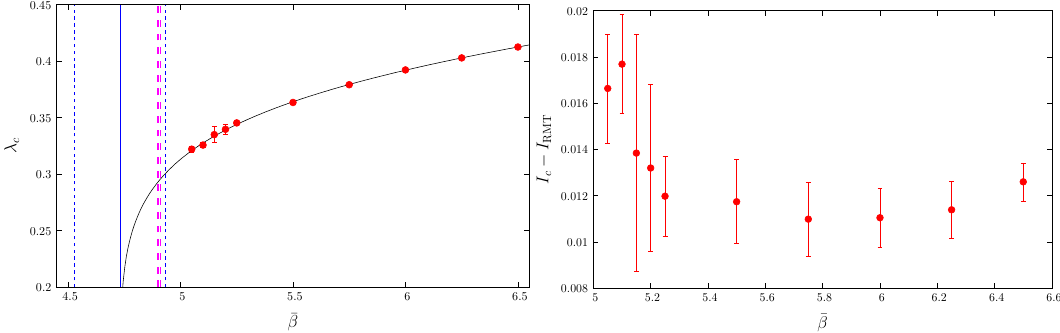
Figure 9 . Mobility edge λ c (in lattice units) obtained via constrained fitting using I λ (left), and deviation of the corresponding value I c of the statistic at the critical point from the RMT value (right). The result of a fit of λ c with eq. (4.8) is also shown (solid line), together with the value ¯ β 0 at which the mobility edge extrapolates to zero and corresponding error band (blue lines), and with the error band for the critical lattice coupling for deconfinement obtained in ref. [49] (magenta